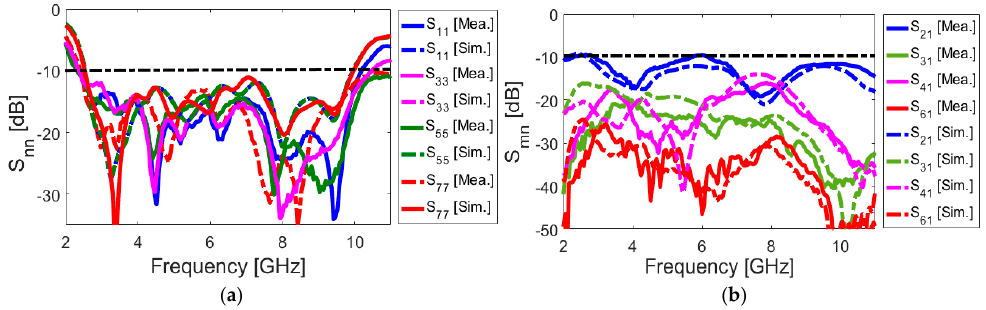
Figure 21. Measured and simulated ( a ) S nn and ( b ) S mn characteristics.